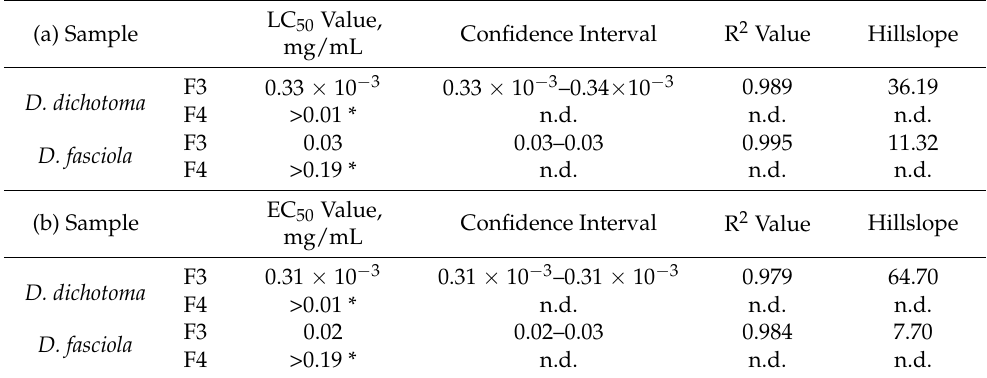
Table 5. Acute toxicity of D. fasciola and D. dichotoma fractions (F3 and F4) obtained upon 96 h of zebrafish D. rerio